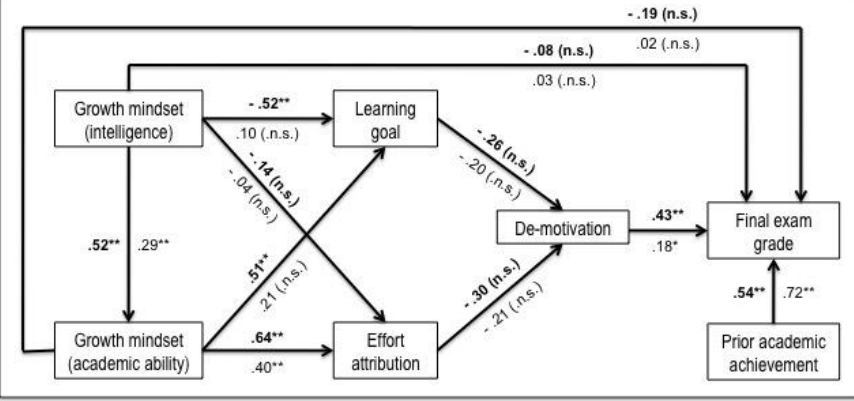
Figure 3. Path analysis results for the subsamples. Figures show standardized regression weights (beta). Figures in bold represent students who experienced setbacks in the mid-term exam. * p< .05; ** p< .01 (two-tailed